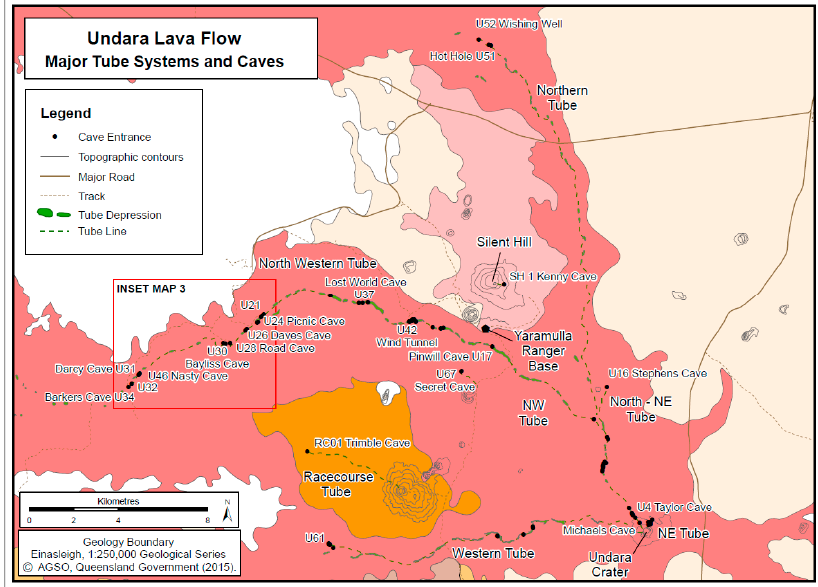
Figure 2. Lava tube systems and caves in the Undara Basalt flow. Bayliss Cave and other major cave segments are labelled. Map adapted from Pearson [35] with permission from Chillagoe Caving Club. Geology boundaries from Queensland Government 1:250,000 Geological Series.